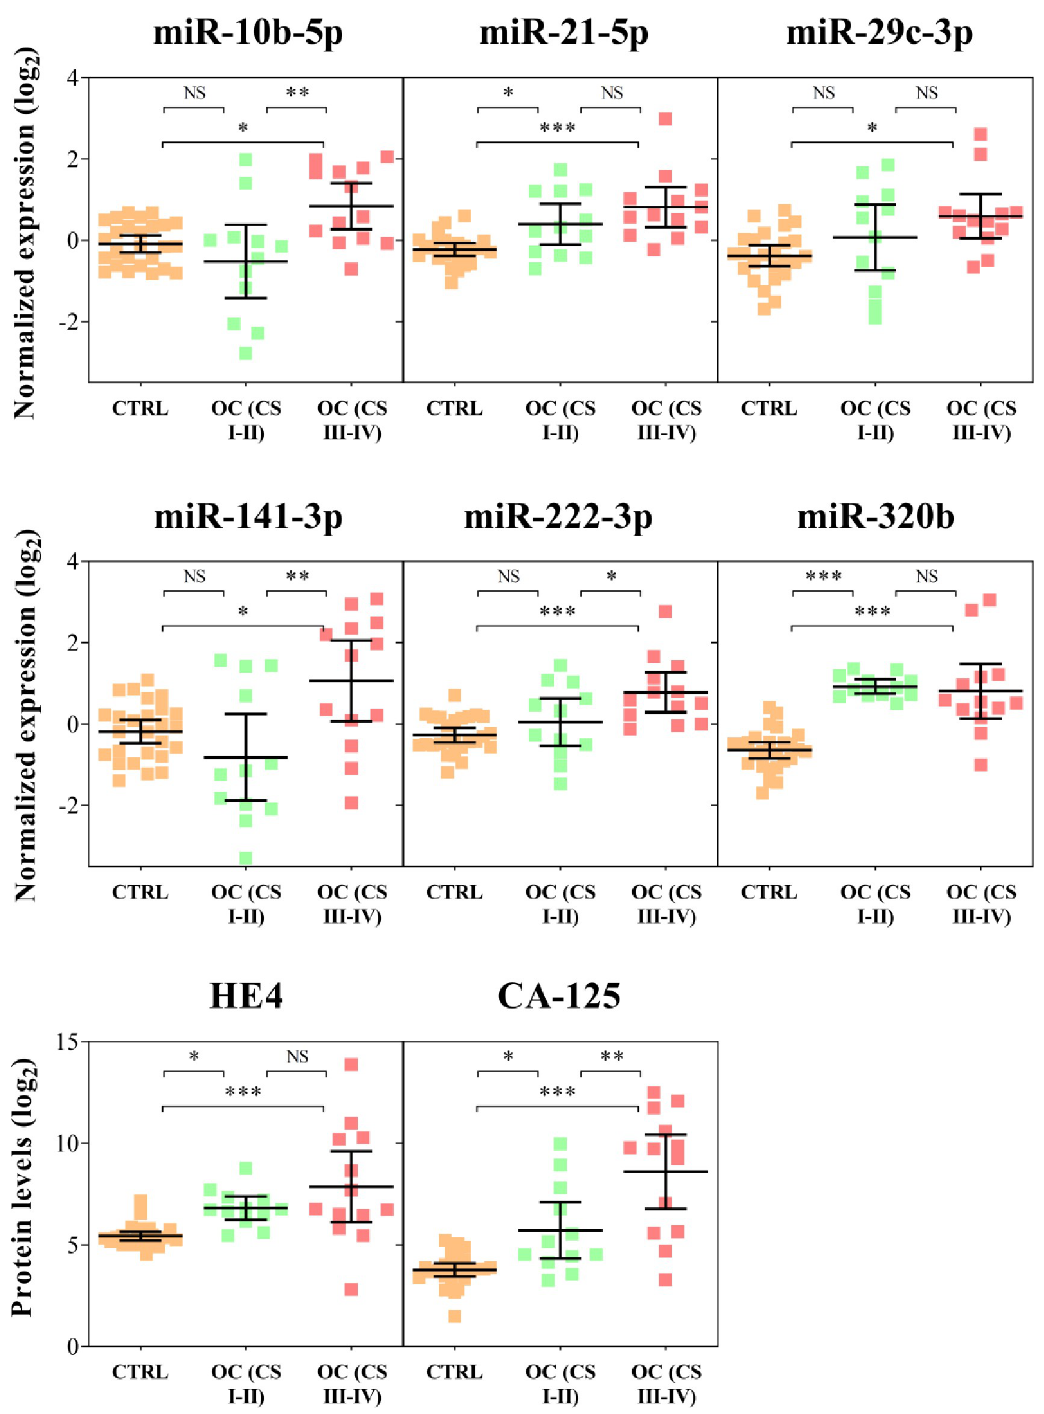
Fig 2. MicroRNAs and proteins that exhibited distinct levels in the serum of ovarian cancer against control cases (Discovery Set). The plot displays the mean and 95% confidence intervals of the log 2 normalized relative quantification of the miRNAs (evaluated by miRCURY Custom ddPCR Assay) and proteins levels (measured by CMIA). For visualization purposes, the normalized miRNA levels were median-adjusted. Orange: controls (n = 26); Green: early stage (I-II) ovarian cancer (n = 12); Red: late stage (III-IV) ovarian cancer (n = 13). � P < 0.05; �� P < 0.01; ��� P < 0.001 (P from Tukey post-hoc with Benjamini-Hochberg correction).